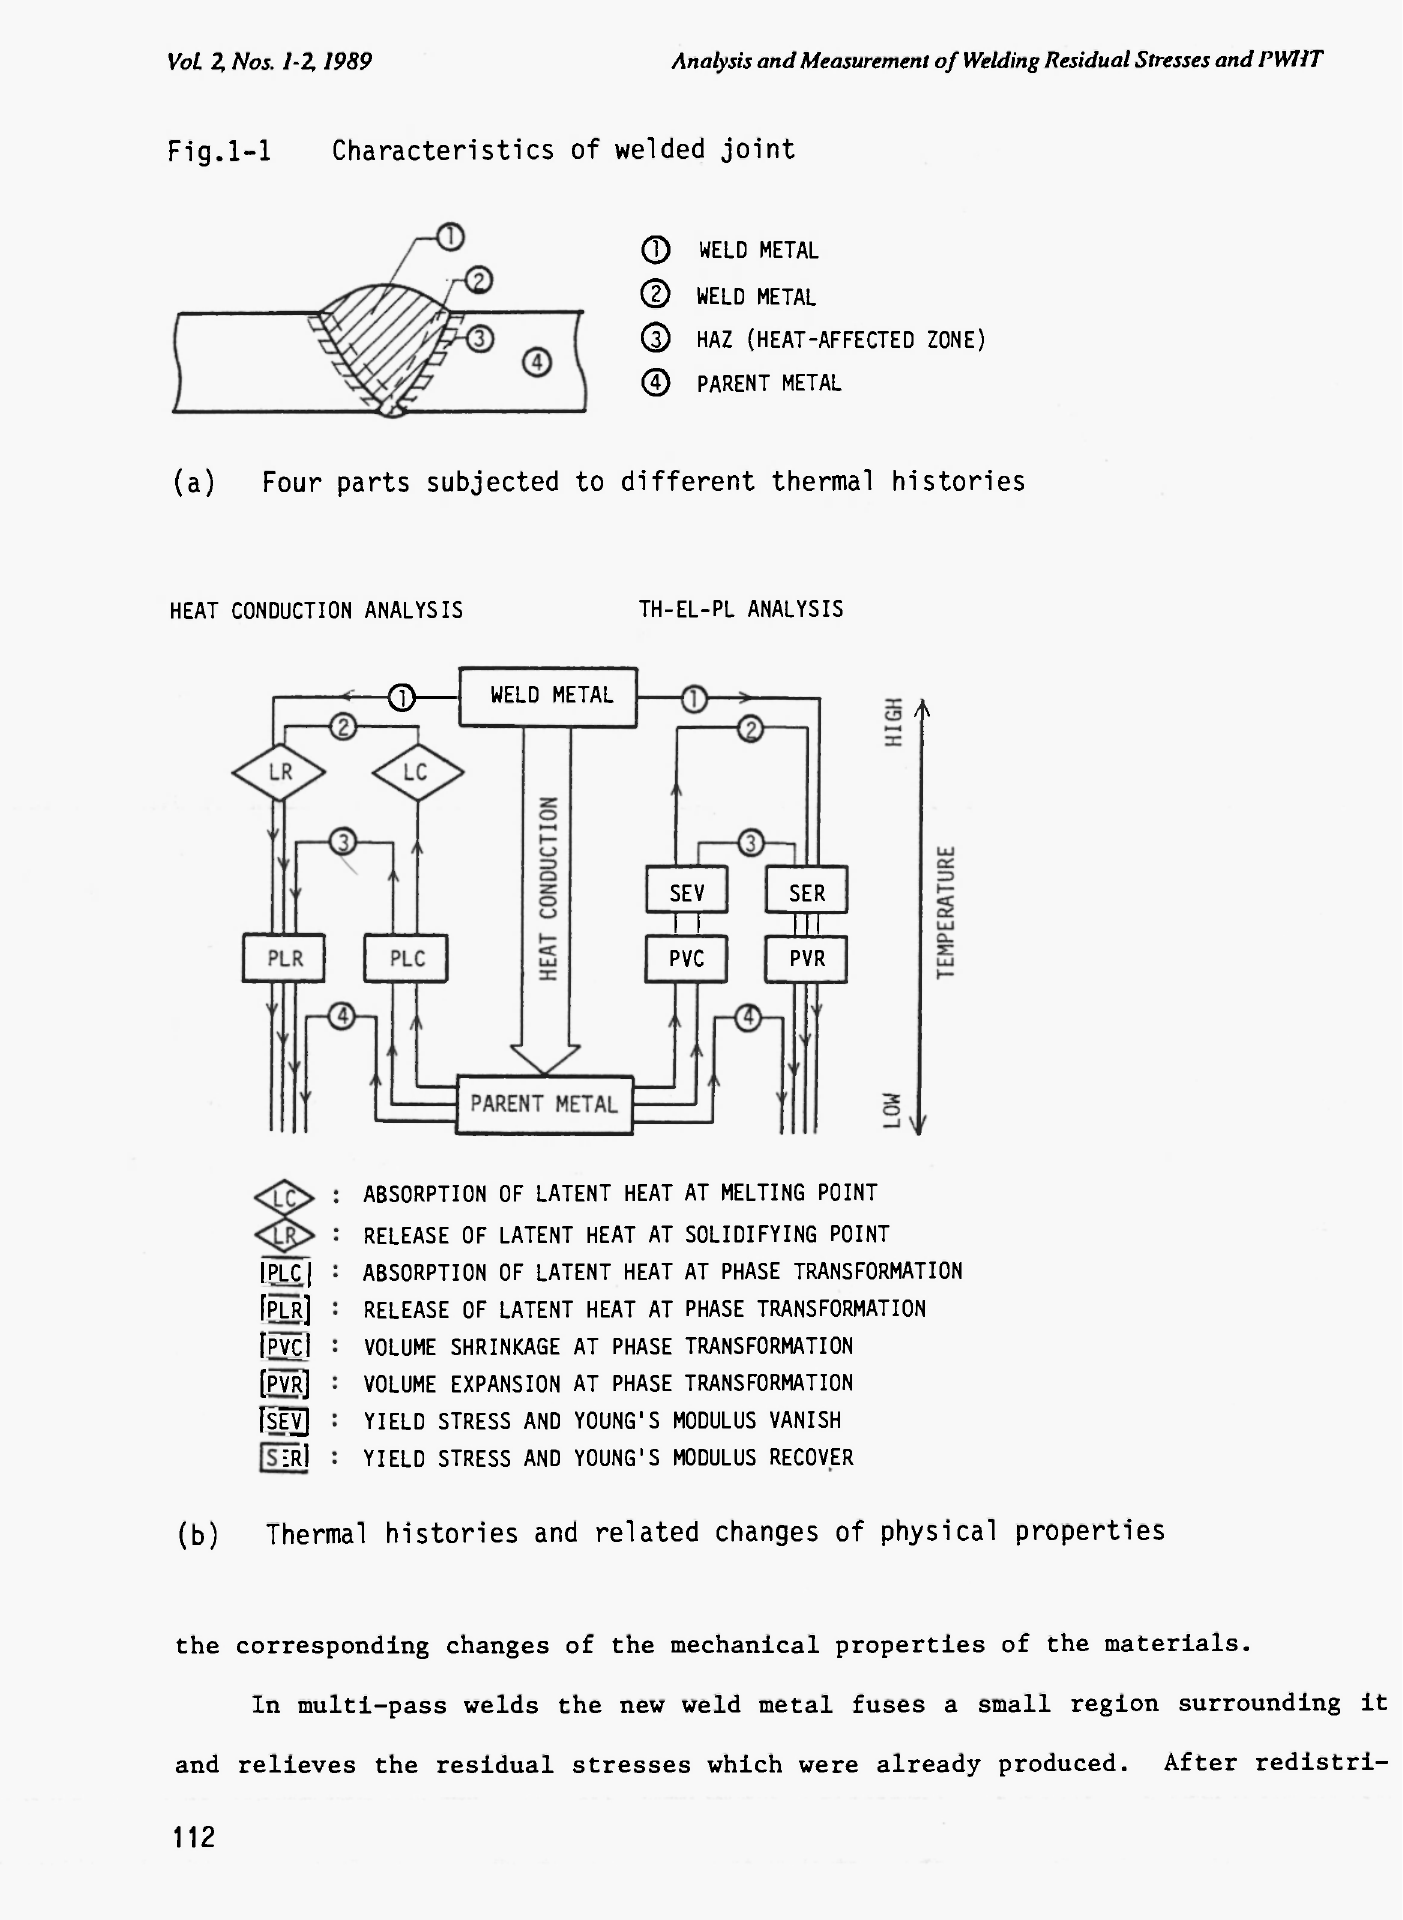
Ο WELD METAL CD WELD METAL © HAZ (HEAT-AFFECTED ZONE) © PARENT METAL